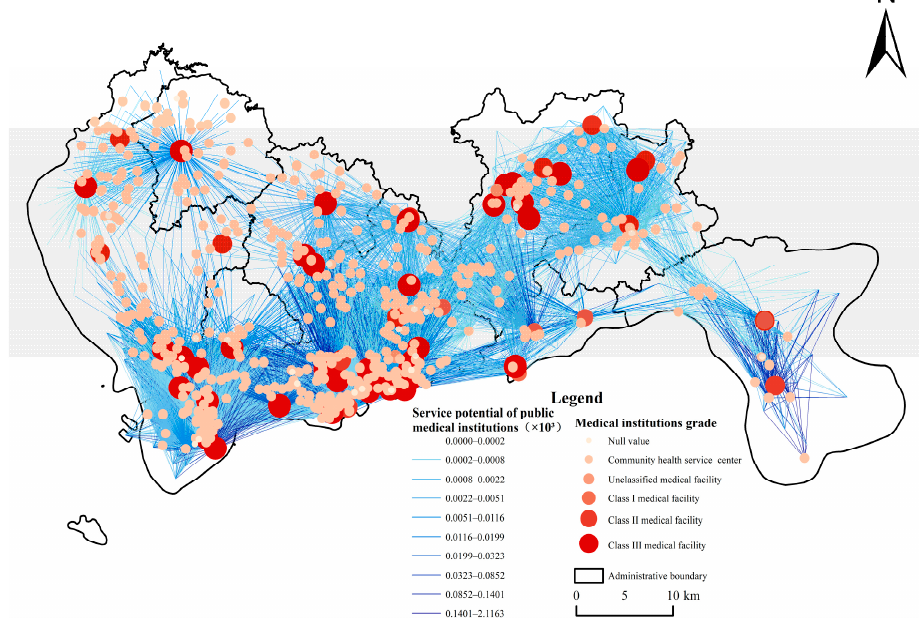
Figure 6. Potential/gravitational attraction of public medical services in Shenzhen.